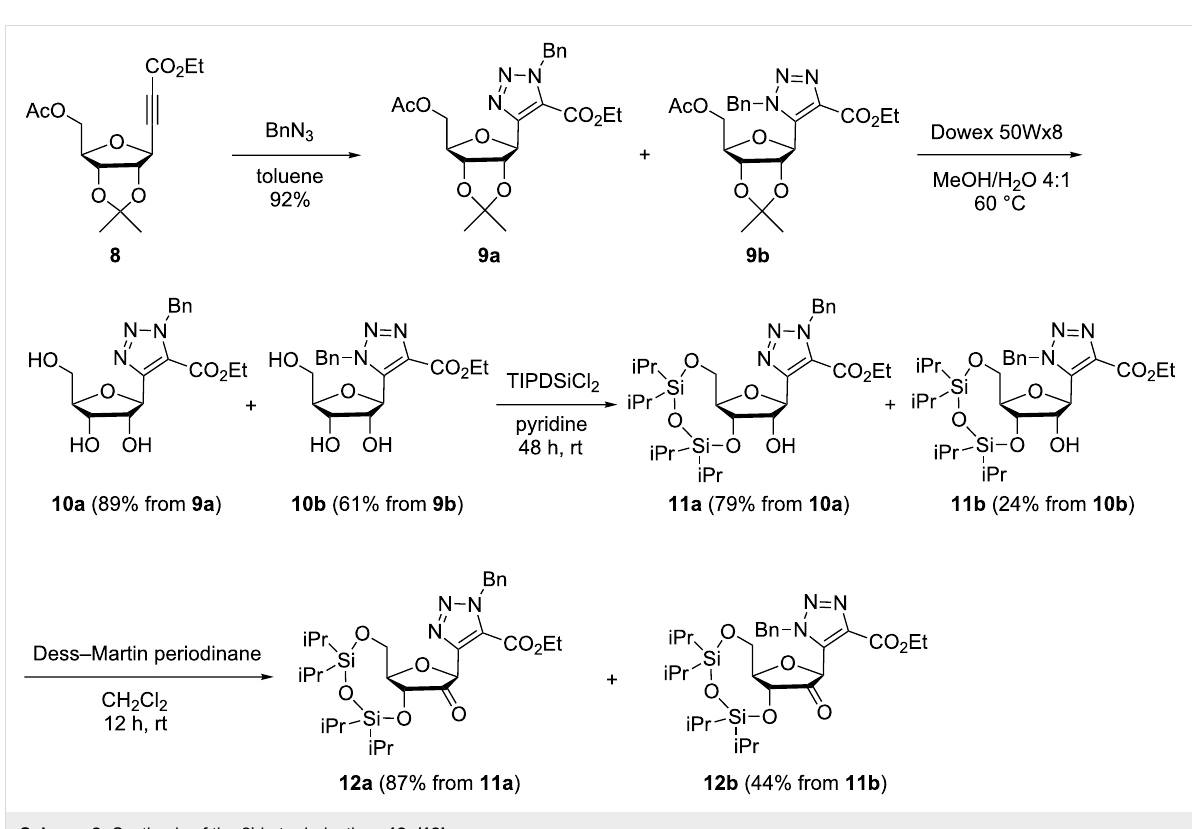
Scheme 2: Synthesis of the 2’-keto derivatives 12a/12b